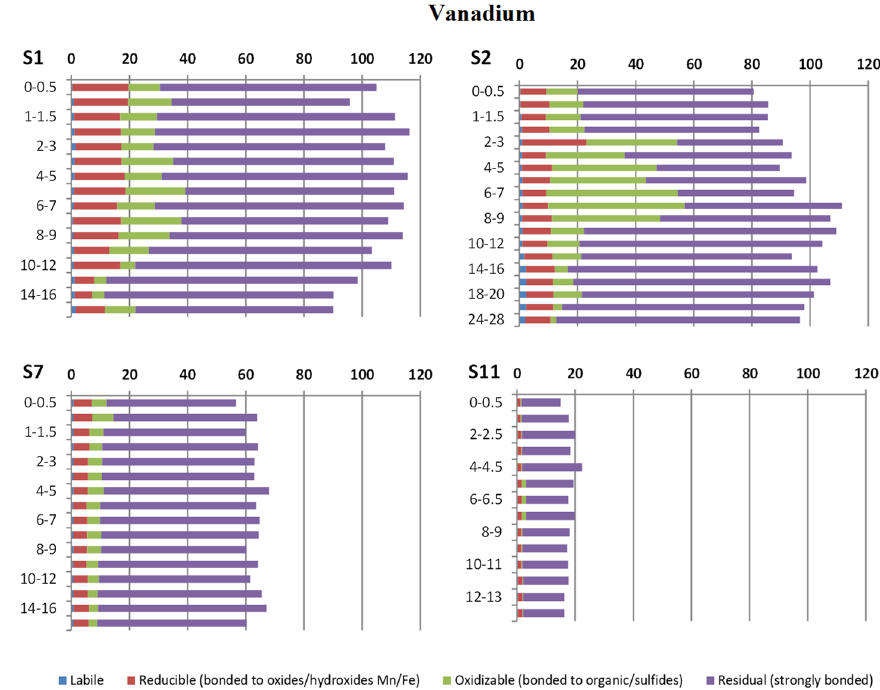
Figure 4. Chemical fractionation of V in sediments from the S1, S2, S7, and S11 stations. Horizontal axis: concentration (mg/kg). Vertical axis: core depth (cm).